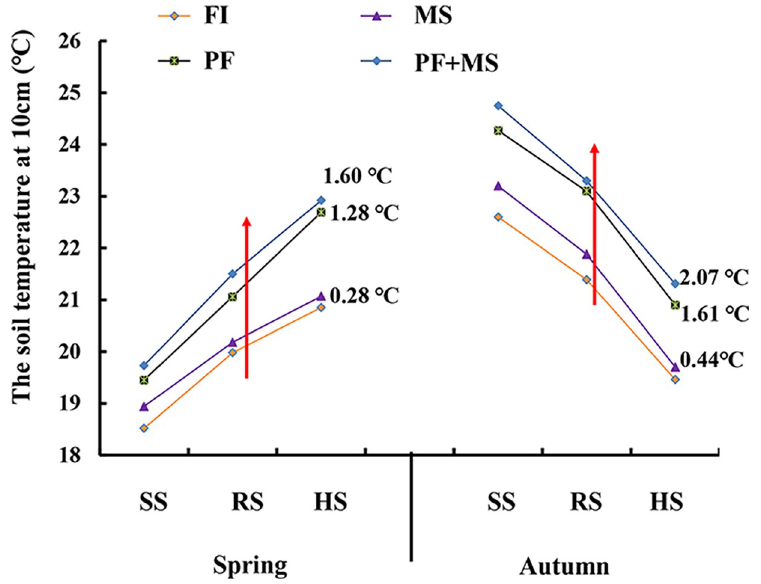
Fig 4. Effects of different irrigation systems on soil temperature at 10cm soil layer at SS (seedling stage),RS (rosette stage), HS (heading stage) in spring or autumn.